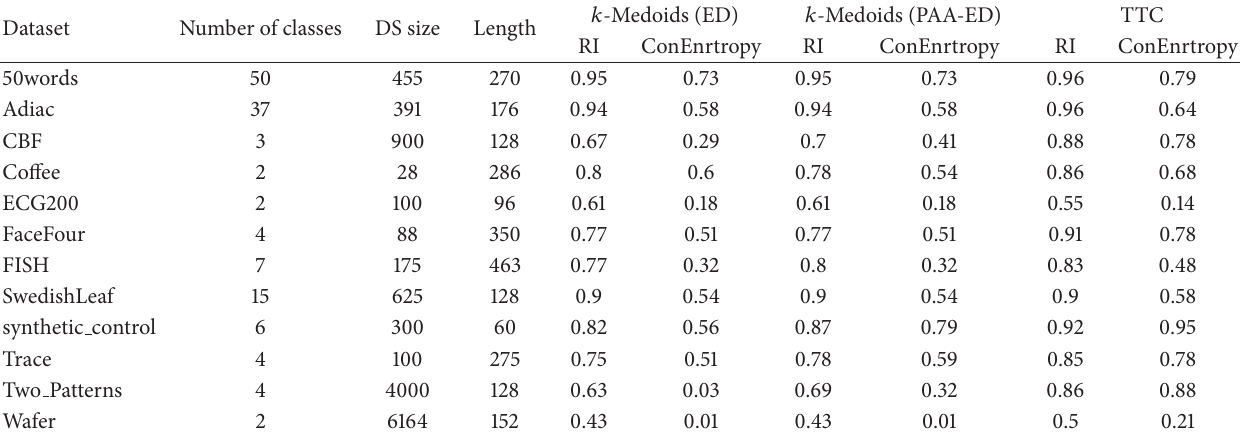
Table 1: Quality of TTC approach against the standard 𝑘 -Medoids with regard to raw time series data and the time series data represented by